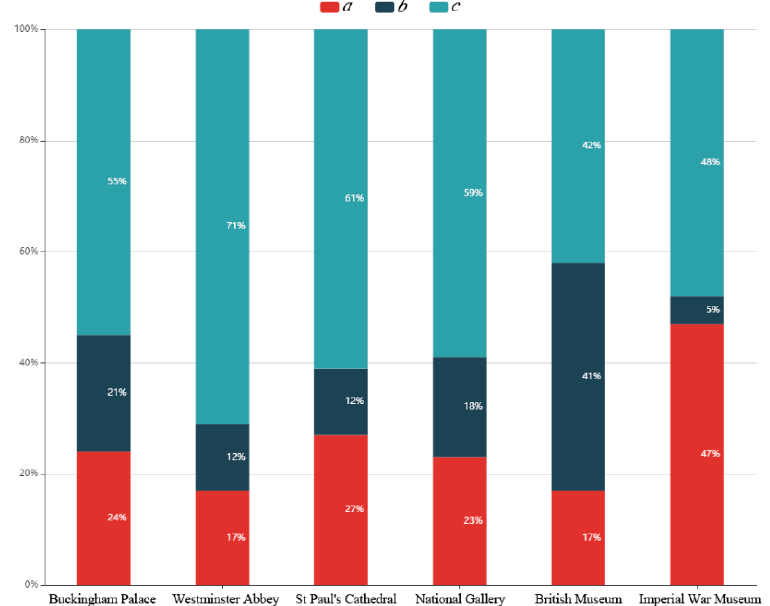
Figure 9. Proportions of category a (semantic-relevant and content-relevant), b (semantic-relevant but content-irrelevant), and c (semantic-irrelevant but content-relevant) images of each landmark.